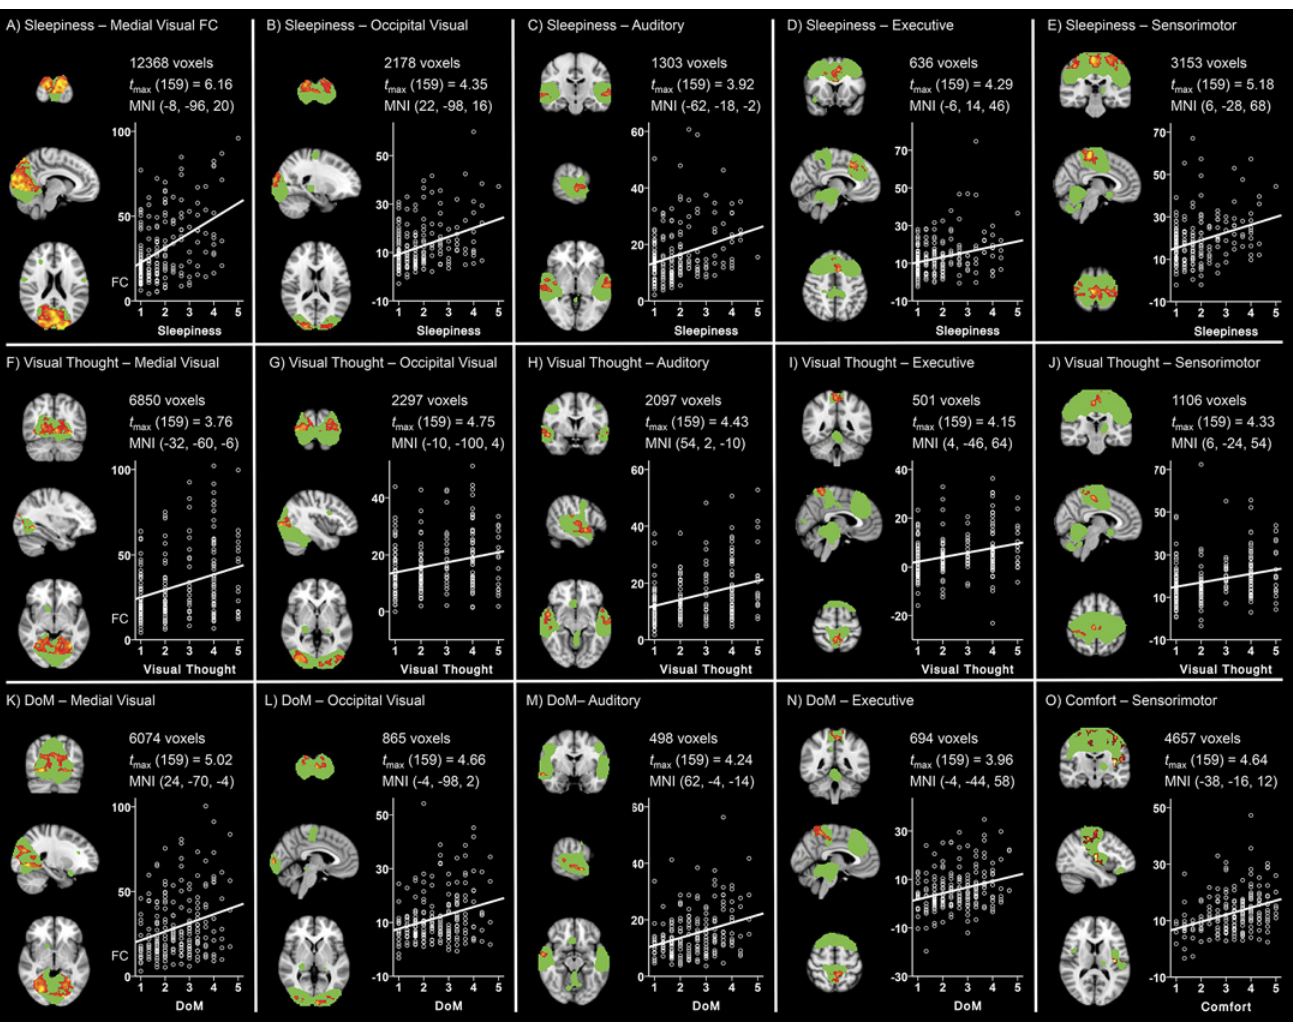
Fig 5. BrainMap-derived ICNs show similar associations with ARSQ scores to those of the ICA maps. A total of fifteen combinations of ICNs and ARSQ dimensions showed significant associations between functional connectivity and ARSQ factor score at a cluster-wise Bonferroni-corrected significance threshold of P FWE = .00025. Orthogonal slices through the peak voxel are shown on the left of each panel; ICNs are defined by the BrainMap spatial maps thresholded at Z = 2.3 and displayed in green, clusters of voxels showing significant associations (2.62 < t < 5) in a gradient from red to yellow, overlaid on a standard brain template in radiological convention (left = right). Number of significant voxels, maximum t -statistic and peak voxel coordinates are displayed at the top right, scatter plots showing the mean functional connectivity value in significant clusters (y-axis) plotted against the relevant ARSQ measure are shown in the bottom right of each